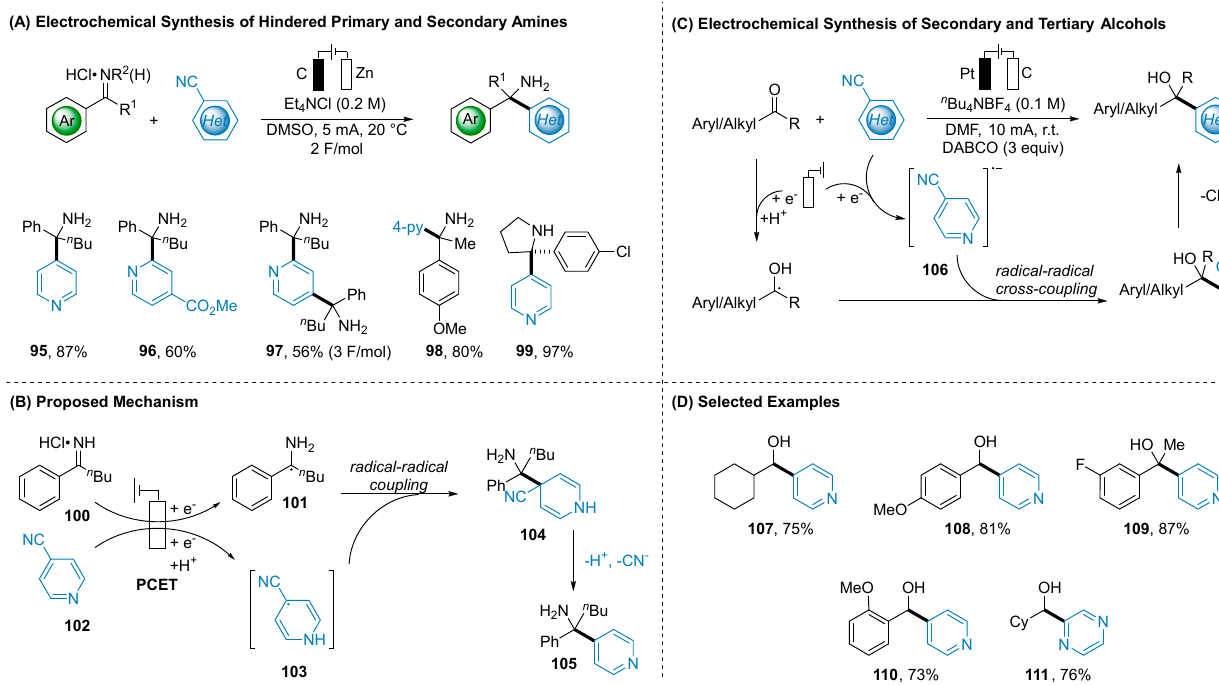
Figure 11. Electroreductive of cyanoheteroarenes with iminium salts or ketones.